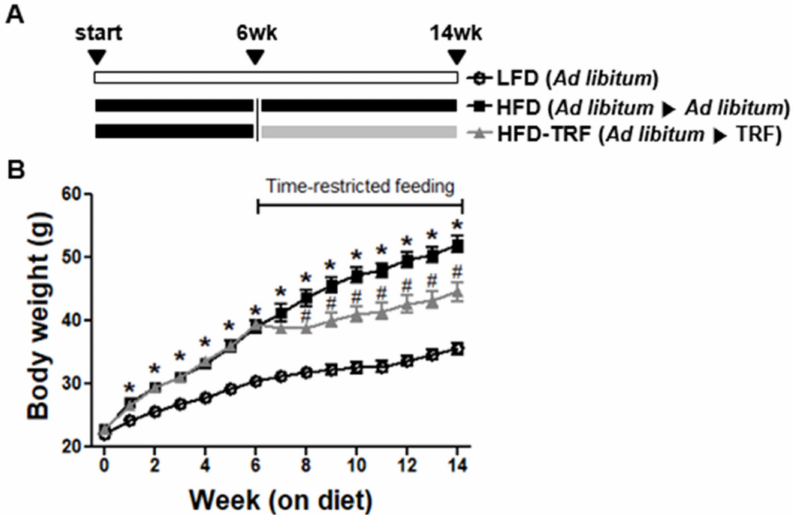
Figure 1. Therapeutic effects of time-restricted feeding (TRF) on body weight. ( A ) Schematic outline of the three feeding regimens used in this study. Six-weeks of C57BL/6J mice were fed low-fat diet (LFD) or high-fat diet (HFD) ad libitum for 6 weeks until 12 weeks of age. The HFD group were further divided two groups for the following regimens: continuous HFD ad libitum or HFD-TRF (10-h/daytime-restricted access to food during active period) for 8 weeks until 20 weeks of age. ( B ) Average body weight ( ± SEM, n = 7 mice). Significant differences among groups were determined by ANOVA followed by post hoc Tukey’s test. HFD, HFD-TRF (vs. LFD), * p < 0.05; HFD-TRF (vs. HFD), # p <